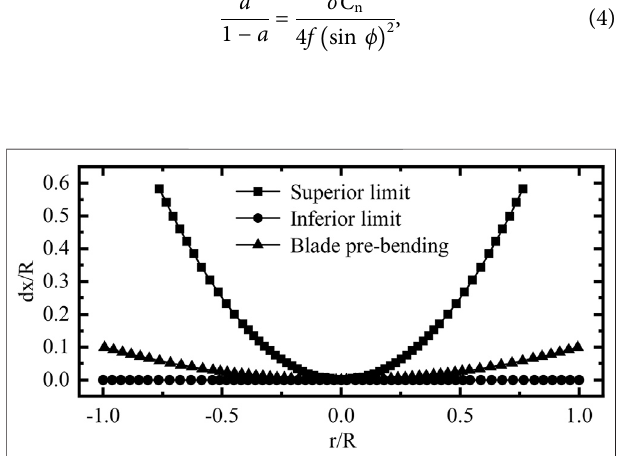
FIGURE 3 | The pre-bending distribution